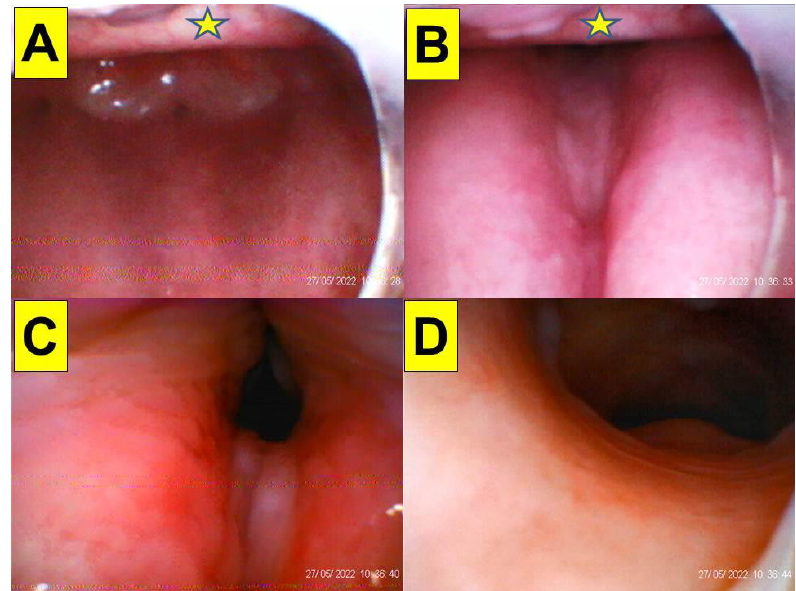
Figure 9. Minimal space beneath the epiglottis, enough for a midline passage of the intubating stylet. ( A ) Lifting up the flat epiglottis by the jaw-thrust maneuver, ( B ) drop of the epiglottis against the posterior pharyngeal wall without jaw-thrust effort, ( C ) full glottis visualization, ( D ) entry into the trachea. The star denoted the epiglottis in ( A ) and ( B ). The patient was a 74-year-old woman (152 cm, 78 kg, BMI 33.7 kg/m 2 , neck circumference 52 cm) who received orthopedic surgery (also see the Supplementary Materials, Video S6). It took 28 s (from the lip to the trachea) to complete the intubating process.